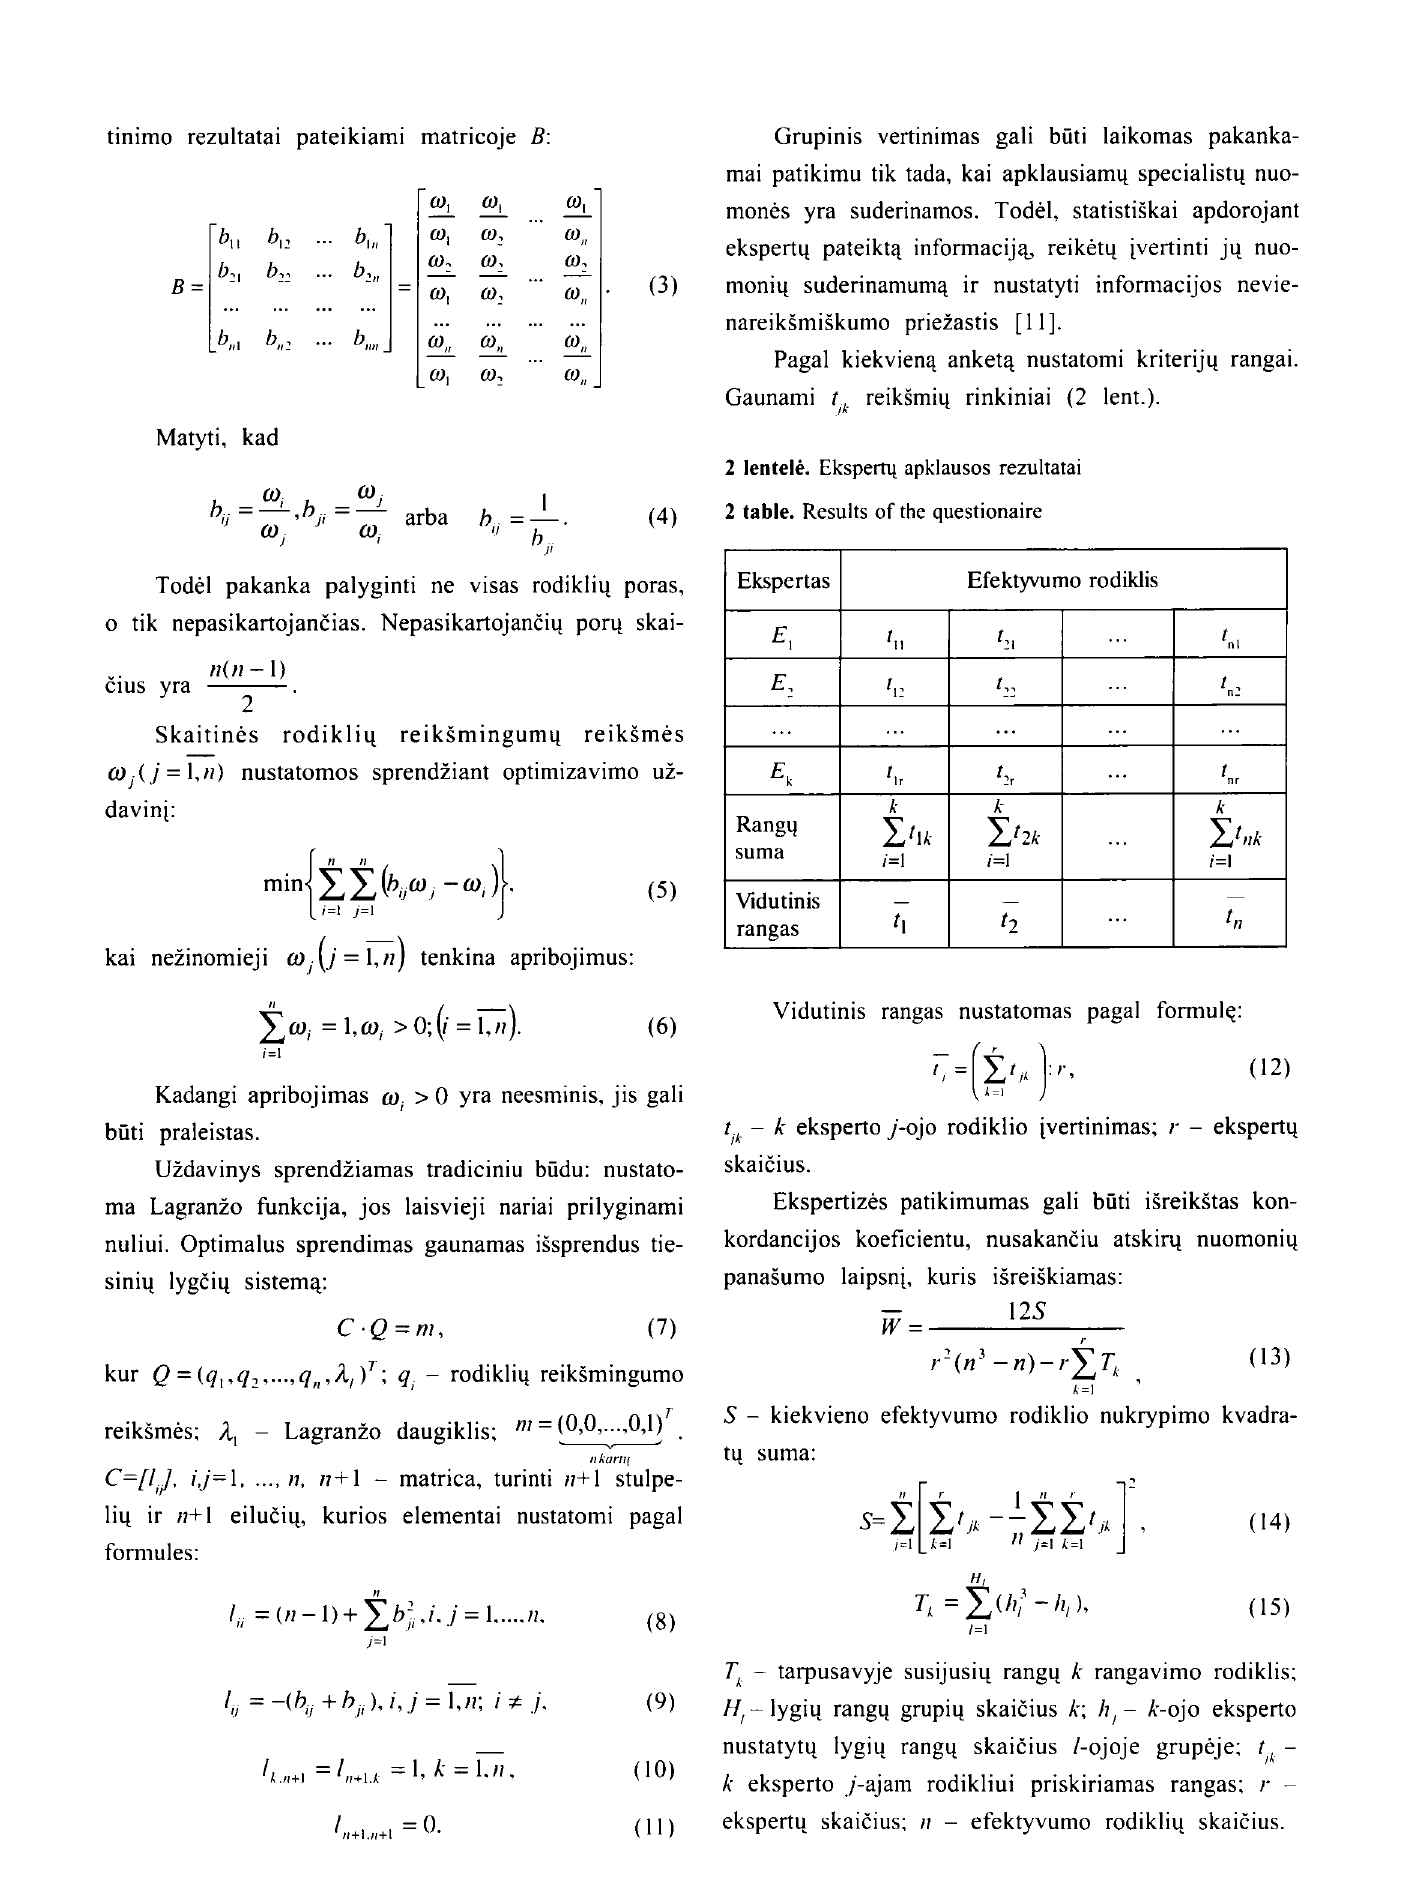
Ekspertas Efektyvumo rodiklis